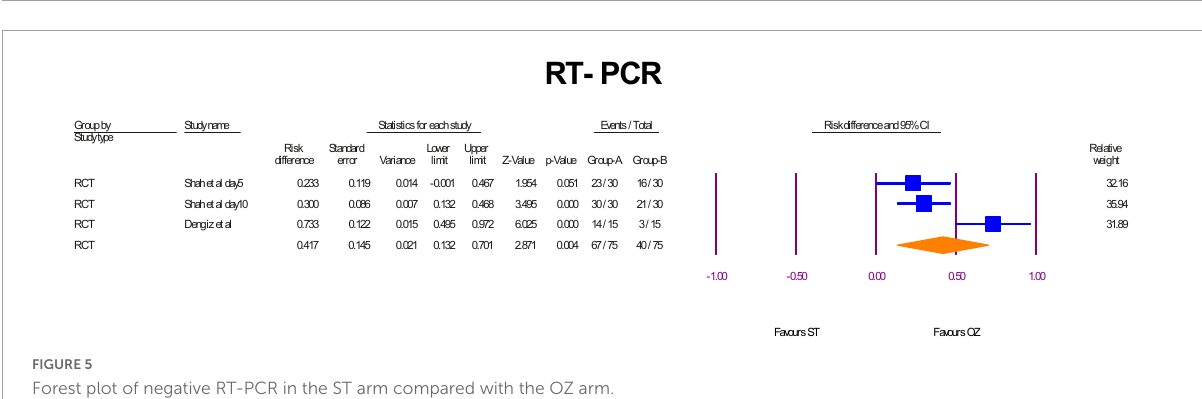
FIGURE4 Forest plot of mortality rate in the OZ arm compared with the ST arm.